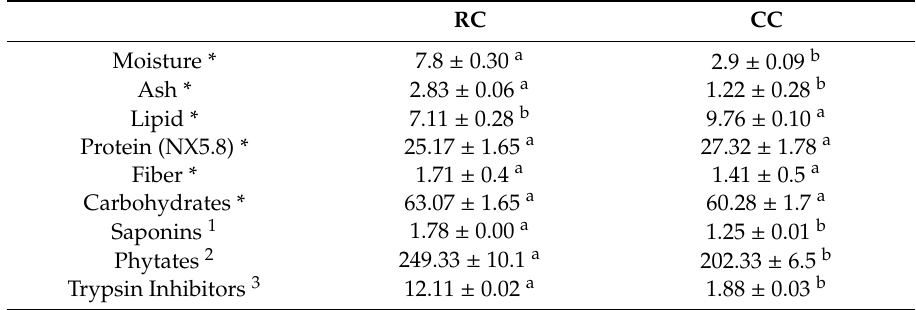
Table 1. Nutritional and non-nutritional chemical analysis of raw (RC) and cooked chickpea flours